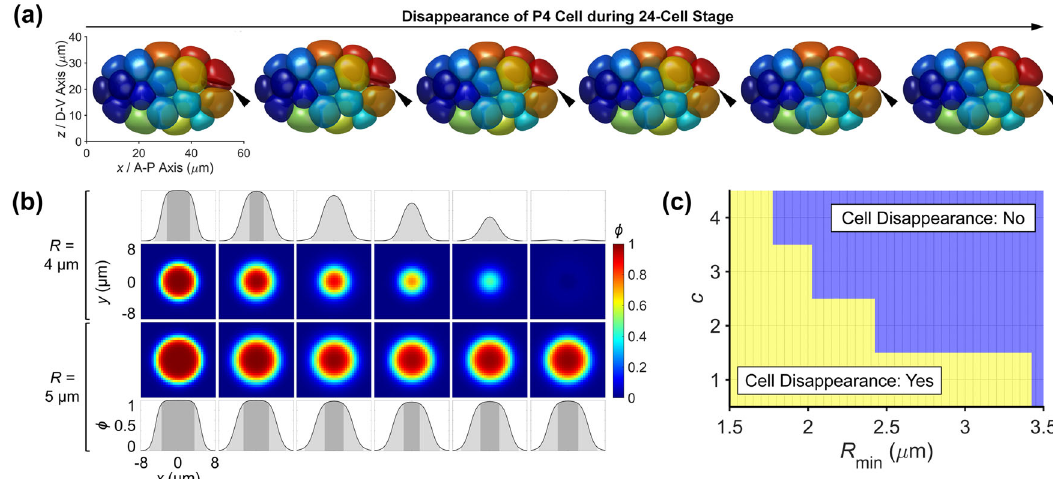
Fig. 3 Cell disappearance that happens when the cell size is too small. a Gradual disappearance of the P4 cell during the 24-cell stage; the P4 cell is colored dark red and pointed by an arrowhead. b Phase fi eld distribution in 1D ( x axis) and 2D ( xy plane) of a free cell with a radius of 4 μ m (upper two rows) and 5 μ m (lower two rows). The single-cell simulation is conducted with open boundaries and illustrated with an in silico interval of 20 from left to right. In the 1D distribution, the boundary of a cell ( 0 : 07 (cid:6) ϕ < 0 : 93 ) is painted with light gray while the interior ( ϕ (cid:7) 0 : 93 ) and exterior ( ϕ < 0 : 07 ) of a cell are painted with dark gray and white respectively. c A scanning on parameter c with different cell radii R min ; yellow and blue indicate if the cell disappears or not in a single-cell